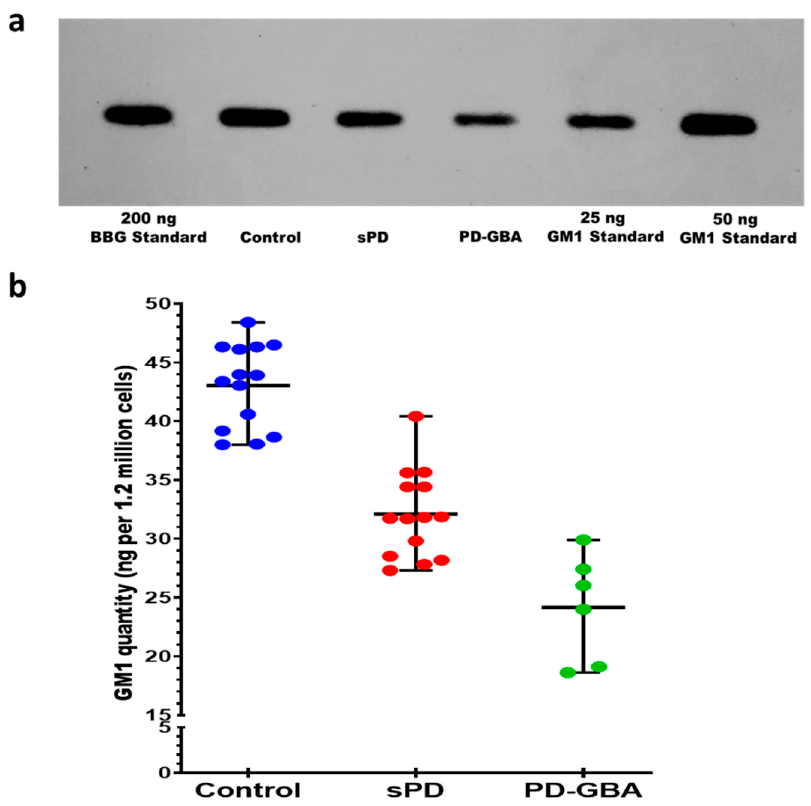
Figure 2. Quantification of GM1 in PBMCs. ( a ) Image of autoradiographic film depicting HPTLC separation and CtxB-HRP detection of GM1 derived from PBMCs from healthy controls, sPD and PD-GBA patients. ( b ) GM1 levels are shown as the mean represented by a solid line and range by upper and lower lines for PBMCs from healthy controls ( n = 14), sPD ( n = 14), and PD-GBA patients ( n = 6). The data were normalized to the amount of lipid fraction applied for 1.2 × 10 6 PBMCs. One-way ANOVA showed a significant difference in GM1 between groups; F(2,31) = 59.62, p < 0.0001. Tukey’s HSD post-hoc testing revealed that sPD and PD-GBA patients both had a significantly lower amount of GM1 compared to healthy controls ( p < 0.0001 respectively). Additionally, PD-GBA patients had a significantly lower amount of GM1 compared to sPD ( p = 0.0005).